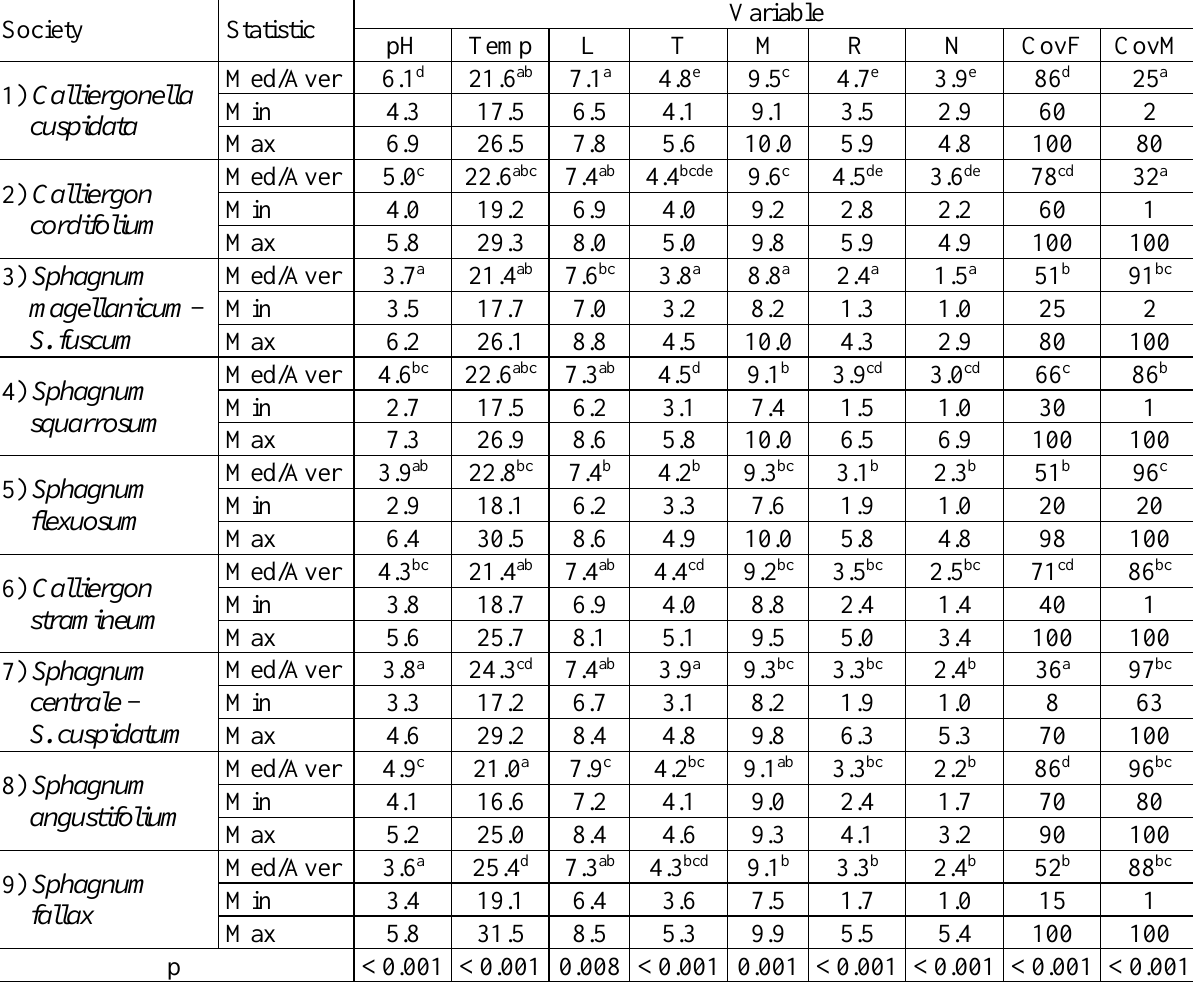
Table 4. Median values of pH and average values of other environmental variables of bryophyte societies. Notation: pH = peat-water pH; Temp = peat water temperature; L, T, M, R, N = Ellenberg indicator values of light, temperature, moisture, reaction and nutrients for synusiae microhabitats, respectively; CovF = field layer (dwarf shrubs + forbs + grasses + sedges) projective cover (%), CovM = moss layer projective cover (%); Min, Max = minimal and maximal values. Superscript letters indicate similar medians according to Duncan’s (for pH values) or Ficher LSD post-hoc tests (for average values of other variables); p = significance level of Kruskal-Wallis median test for pH values, significance level of univariate ANOVA for other